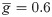
Relative root mean squared errors (RRMSE) (%) of CDS and strip transect estimators estimators (strip widths ranging from 0 to 1) of N, for 4 detection functions, with E[n] = 100, P = 0.1 and g¯=0.6.